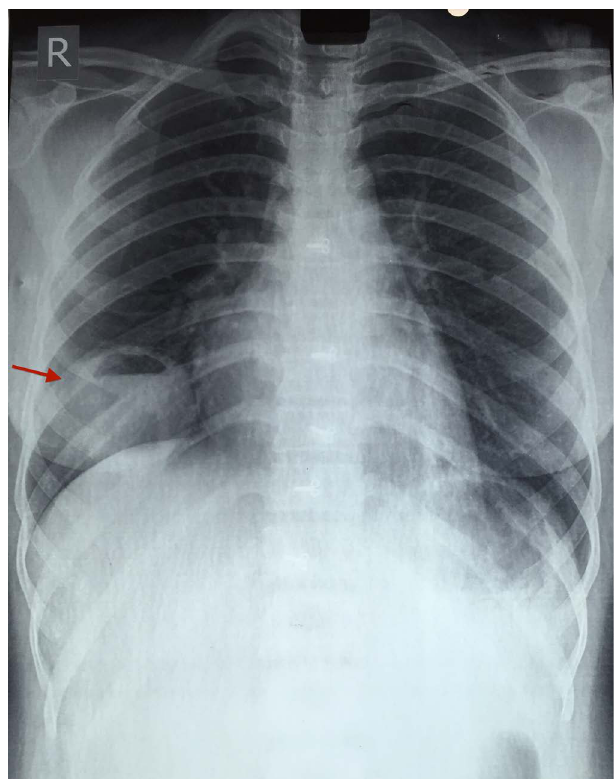
Fig. 1 – PA chest radiography view showing a well-defined lesion (arrow) in the right lower zone of the lung with air fluid level.